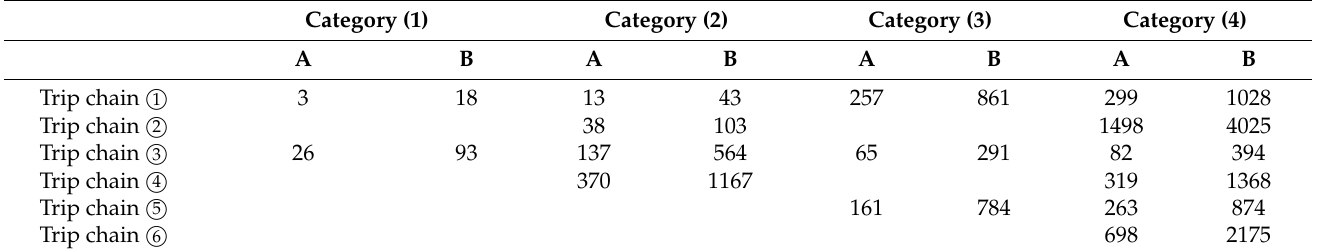
Figure 10. Trip plan selection results. Table 8. Trip chain selection results.